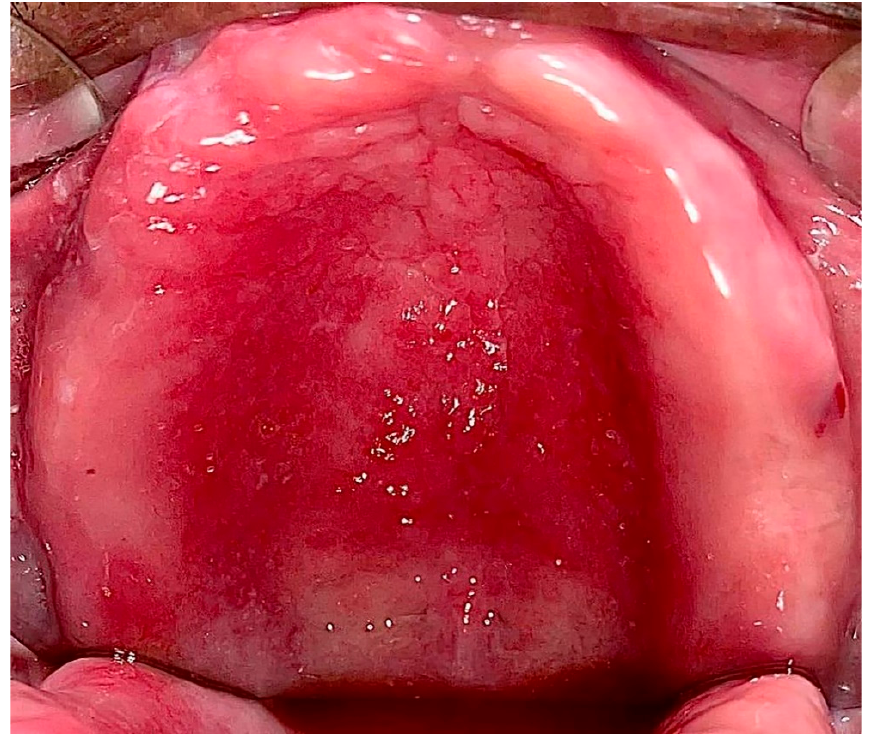
Figure 1. Diffuse involvement of the denture-bearing mucosa in a patient with an upper full denture.